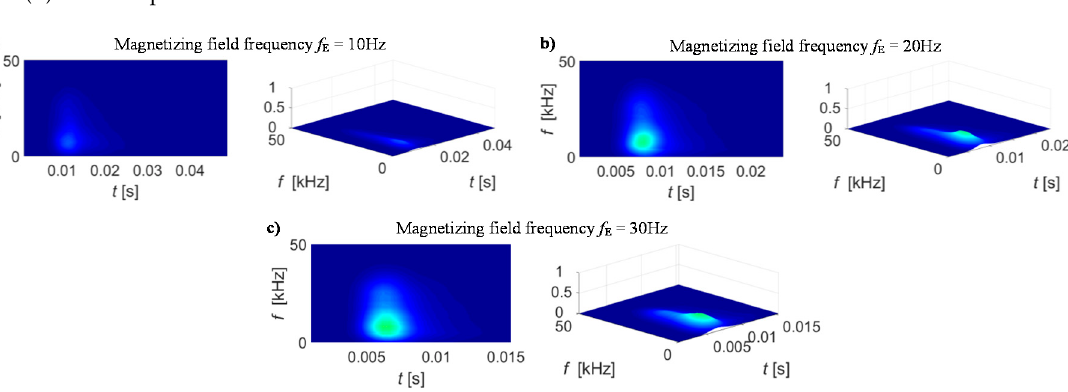
Figure 7. View of spectrograms for different magnetizing field frequency f E : ( a ) 10 Hz ( b ) 20 Hz ( c ) 30 Hz.